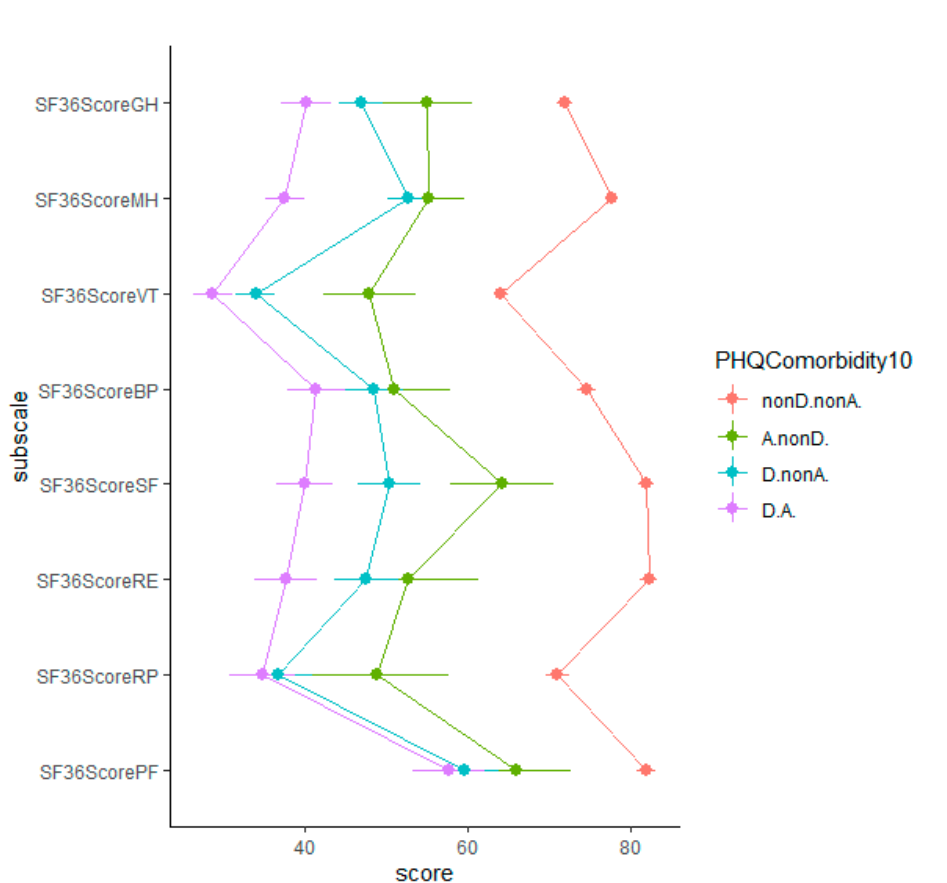
Table A3. Depression and anxiety groups at three months predicting depression and anxiety (cut-off point of 8) at six months using logistic regression.